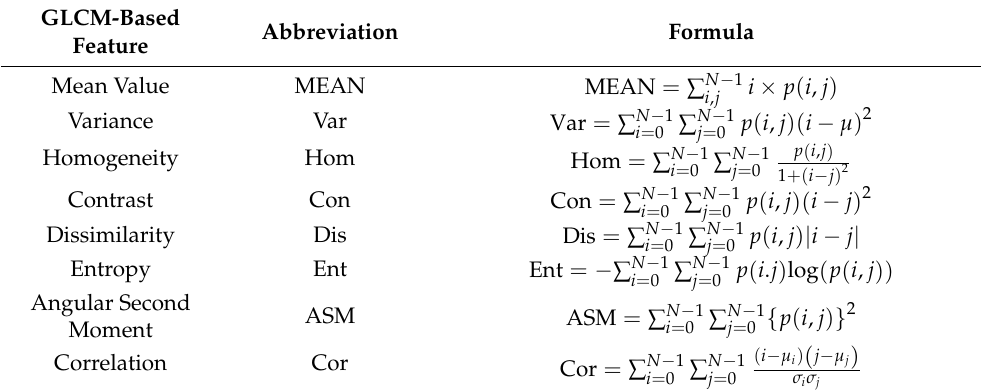
Table 2. Texture features extracted from multispectral images.